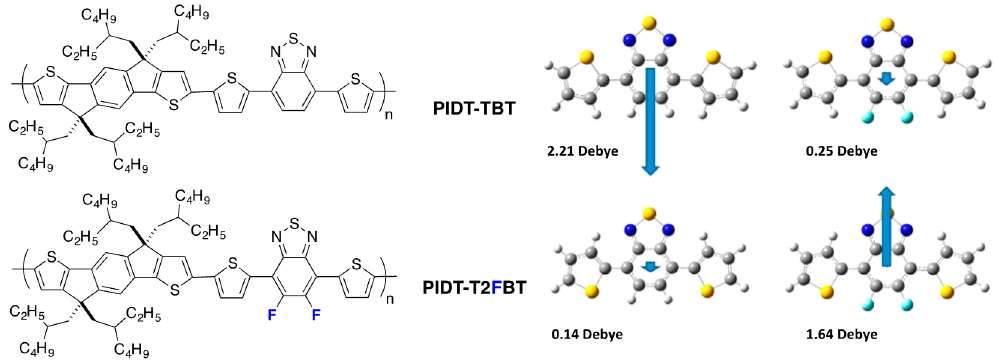
Figure 6. Chemical structure of PIDT-TBT and PIDT-T2FBT and the calculated dipole moment for the DTBT and DTF2BT trimers (adapted with permission from [39]; Copyright 2013 American Chemical Society).